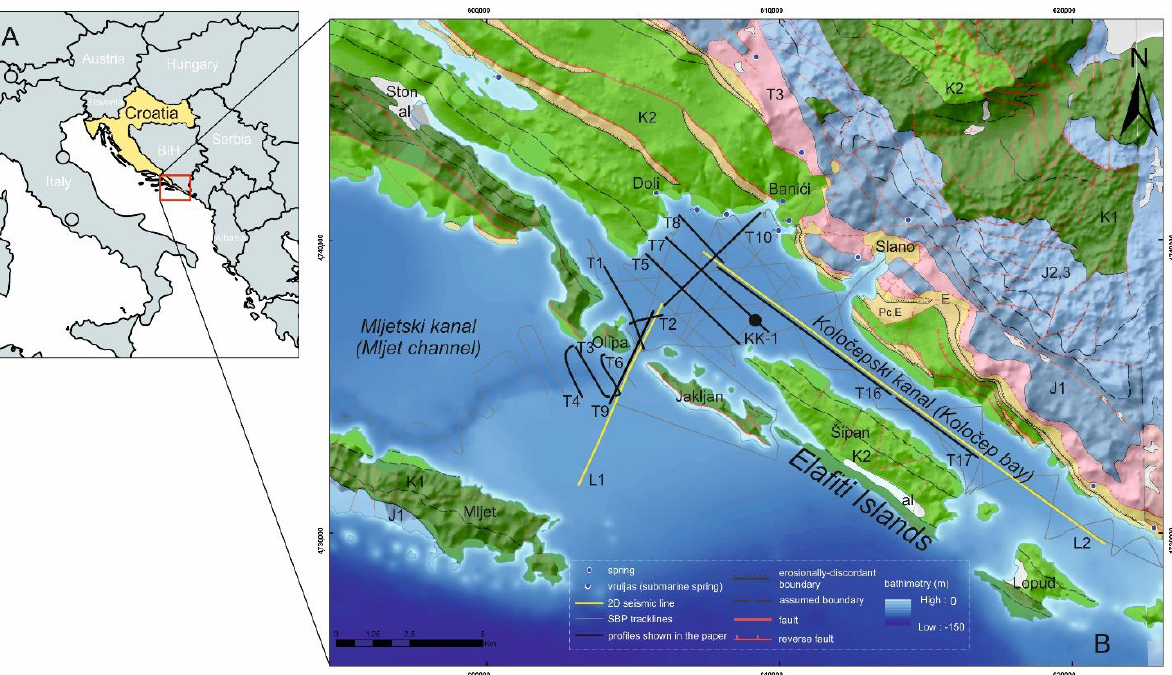
Figure 1. ( A ) General study site location is in the red square; ( B ) bathymetry data of Koločep bay and geological map (geological map modified from [27,28]) draped over shaded relief with plotted sub-bottom profiler (SBP) tracklines, 2D seismic lines, and KK-1 sediment core location marked with black point on trackline 17. Legend: T = Triassic; J = Jurassic; K = Cretaceous; Pc = Paleocene; E = Eocene; al = alluvium (Quaternary).